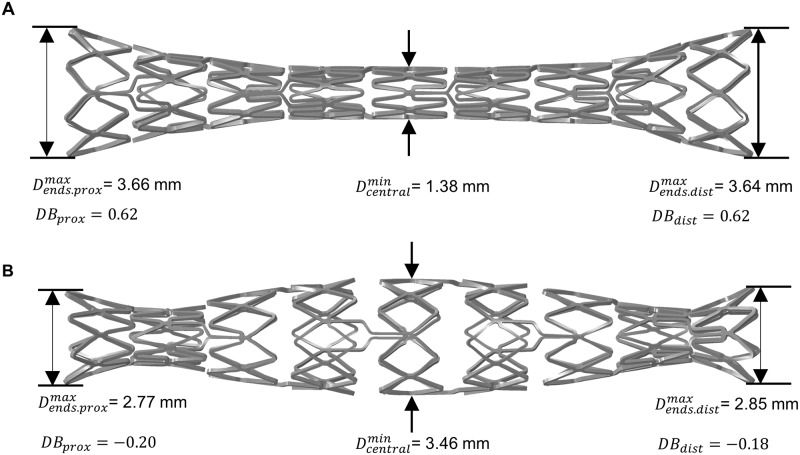
Determination of the dogboning ratio for stent within the stent life-cycle simulation.A: Stent V1 with a typical pronounced dogboning ratio, B: Stent V2 with a rather untypical dogboning ratio due to the heterogenous stent design.